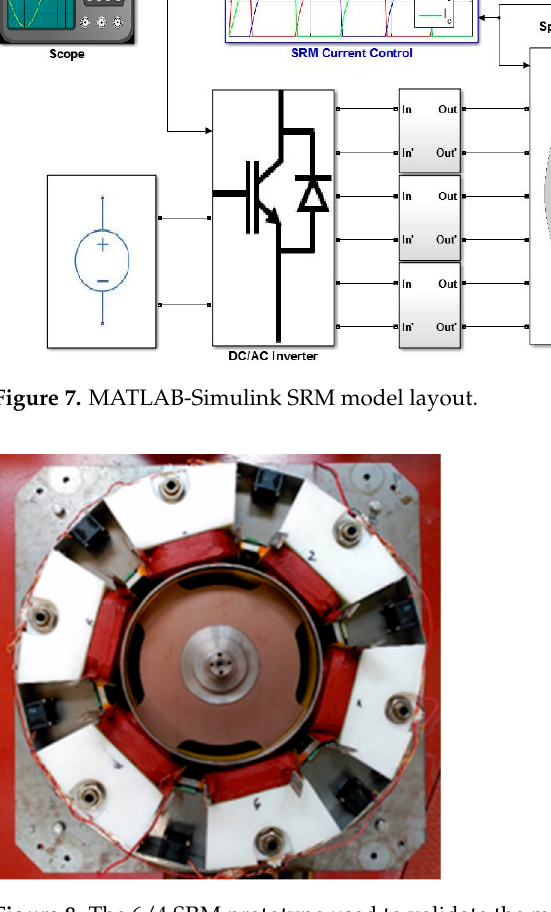
Figure 8. The 6/4 SRM prototype used to validate the mathematical model.